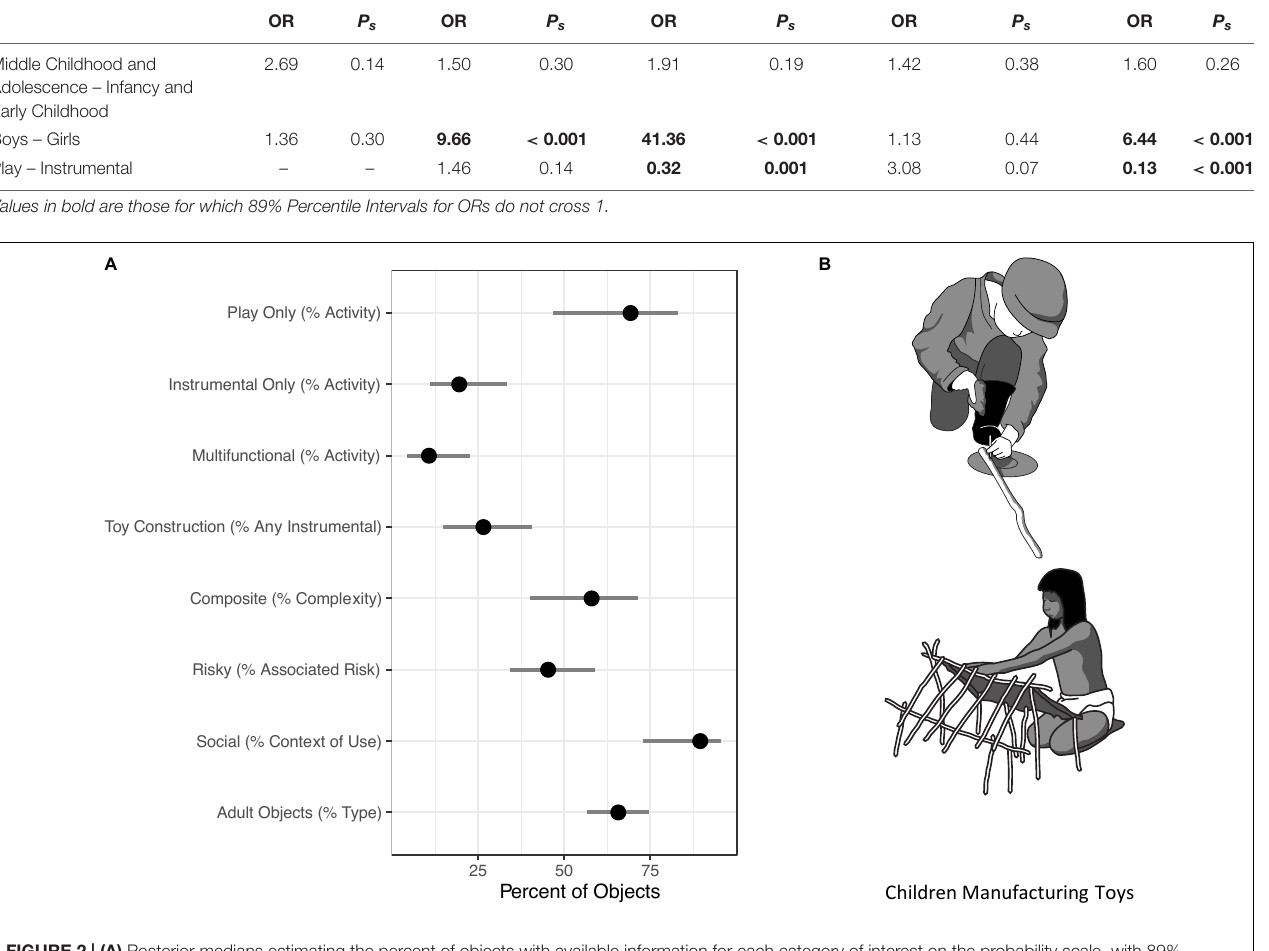
FIGURE 2 | (A) Posterior medians estimating the percent of objects with available information for each category of interest on the probability scale, with 89% Percentile Intervals reflecting associated uncertainty. Note that the category “Any Instrumental” includes both “Instrumental Only” and “Multifunctional” (B) Top: A five-year-old Kaska boy making a rolling toy with the cover of a vacuum tin. Redrawn by Ea Rasmussen (Moesgård Museum) from Honigmann and Bennett (1948). Bottom: A Canela girl making a toy house just outside the village circle of houses. Redrawn by Ea Rasmussen (Moesgård Museum) from Crocker